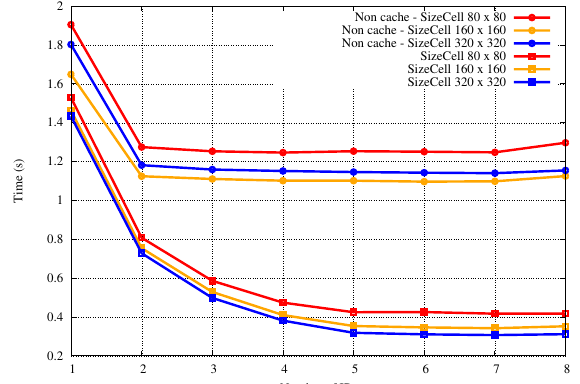
Figure 12. Time of resampling part in function of number of hard- ware IPs used.